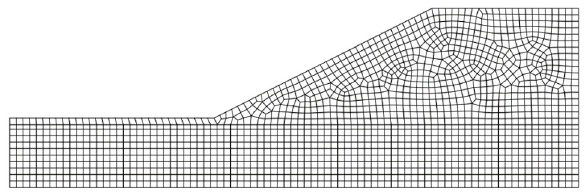
Figure 11. Mesh for Example 2.